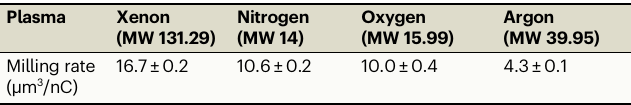
Table 1 | Measured miling rates taken from triplicate mea- surements on plunge-frozen yeast samples